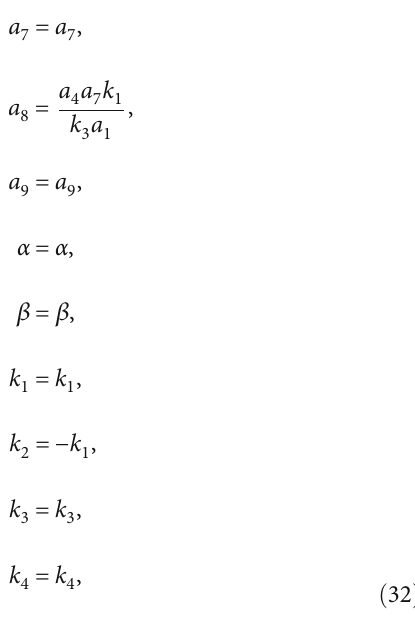
Figure 6: Pro fi les of the solution u via (17a) with a with the time t = 0 ; (b – d) the corresponding density plots with di ff erent